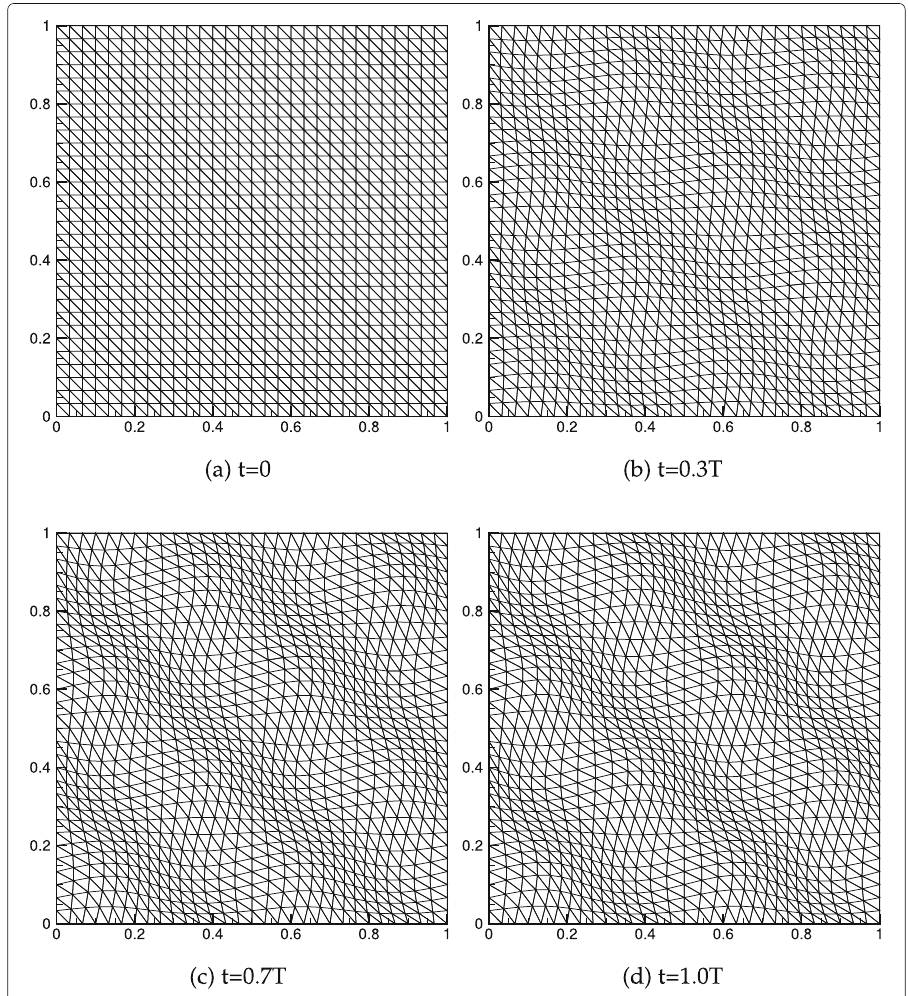
Fig. 2 Mesh deformation for the uniform flow test